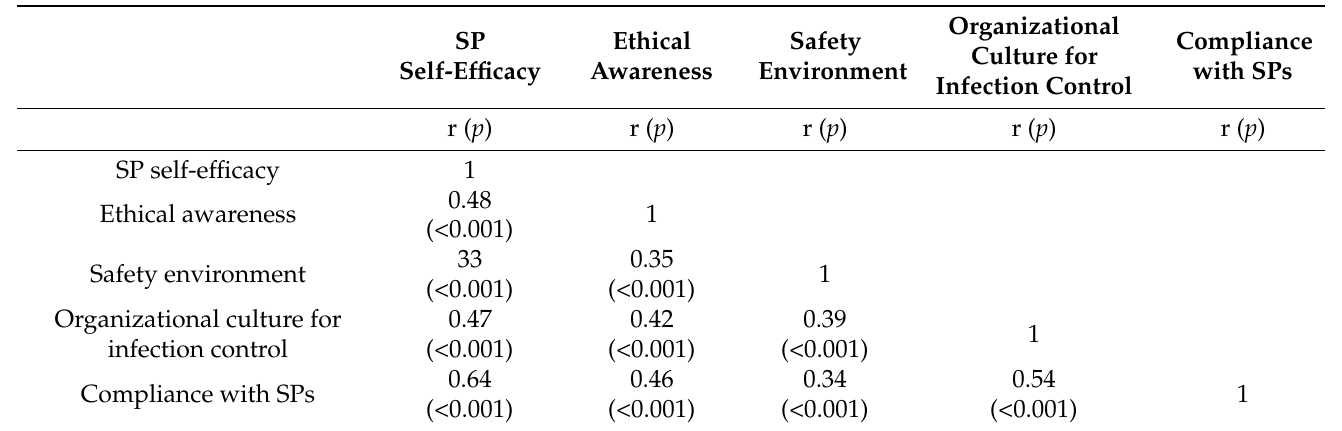
Table 3. Correlations among factors related to SPs (N =